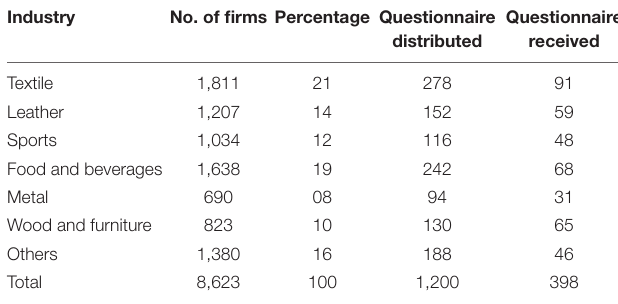
TABLE 1 | Sample distribution by